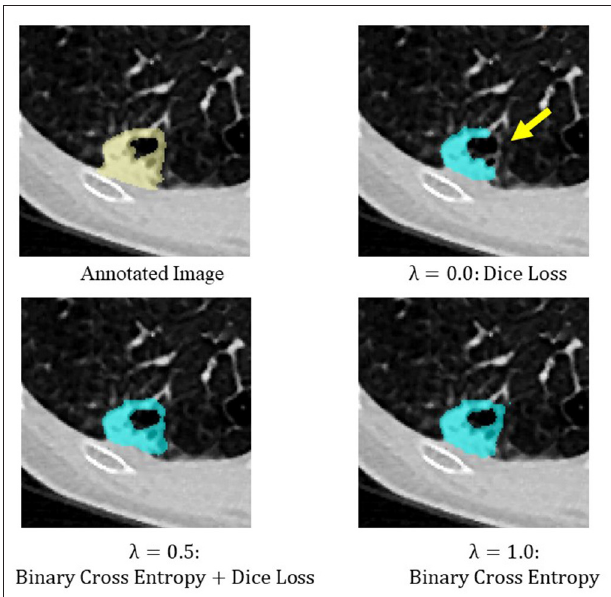
FIGURE 6 | An example of extraction results when the value of λ was changed. Over-extraction was observed when only binary cross entropy was used as the loss function ( λ =